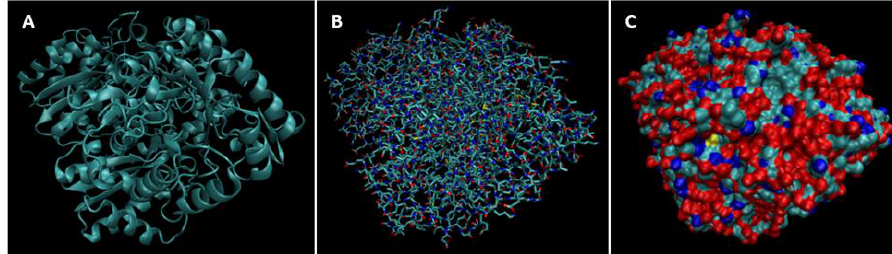
Figure 17. ( A ) A cartoon model, ( B ) a bonds model, and ( C ) a surface model of S100B.